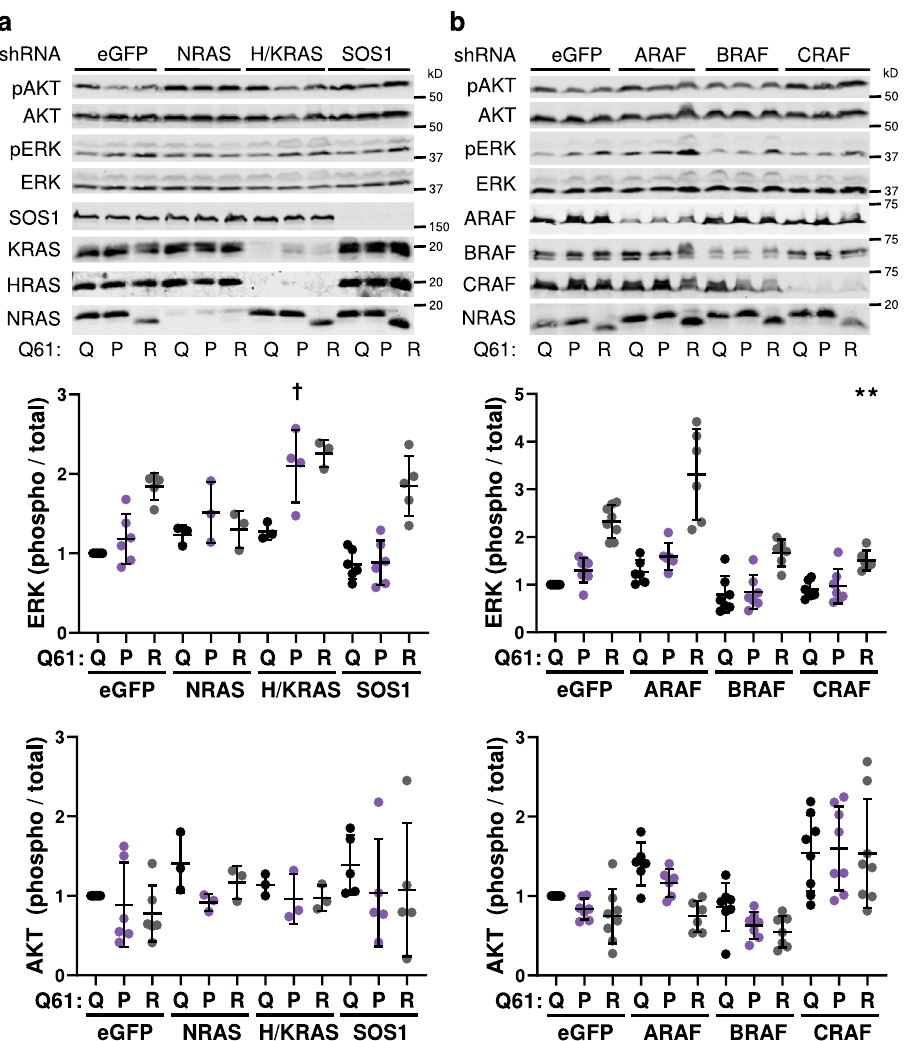
Fig. 5 Oncogenic NRAS mutants mediate differential MAPK activation via a RAF-dependent mechanism. Representative immunoblots of AKT and ERK activation in homozygous MEF cell lines treated with shRNAs targeting Nras , Hras and Kras , or Sos1 ( a ) or Araf , Braf or Craf ( b ). Dot plot data are presented as mean values + / − SD where each dot represents one biological replicate. For a the following biologically independent replicates per genotype were examined over fi ve independent experiments (eGFP arm: Q = 5, P = 5, R = 5; NRAS arm: Q = 3, P = 3, R = 3; H/KRAS arm: Q = 3, P = 4, R = 3; SOS1 arm: Q = 5, P = 5, R = 5). For b the following biologically independent replicates per genotype were examined over 8 independent experiments (eGFP arm: Q = 8, P = 8, R = 8; ARAF arm: Q = 6, P = 6, R = 6; BRAF arm: Q = 7, P = 7, R = 6; CRAF arm: Q = 7, P = 7, R = 6). Adjusted p -values were generated using a one-way ANOVA with a Tukey ’ s multiple comparisons test. Statistics denoted in the fi gure indicate signi fi cant differences between shRNA-treated NRAS mutant MEFs and their respective eGFP control. ** p < 0.01, † p < 0.001. A complete list of adjusted p -values can be found in Supplementary Table 4a, b. Source data are provided as a Source Data fi